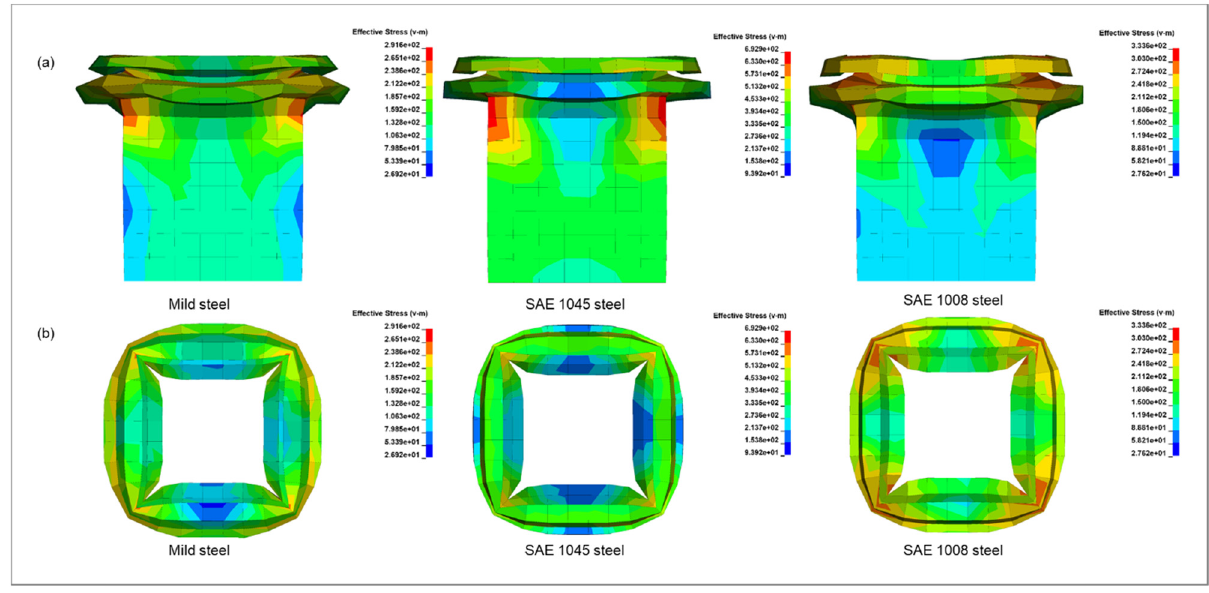
Figure 19: Distribution of the von - Mises stress on the specimen scaling the time from 0.01 to 1 s. ( a ) Side view and ( b ) top